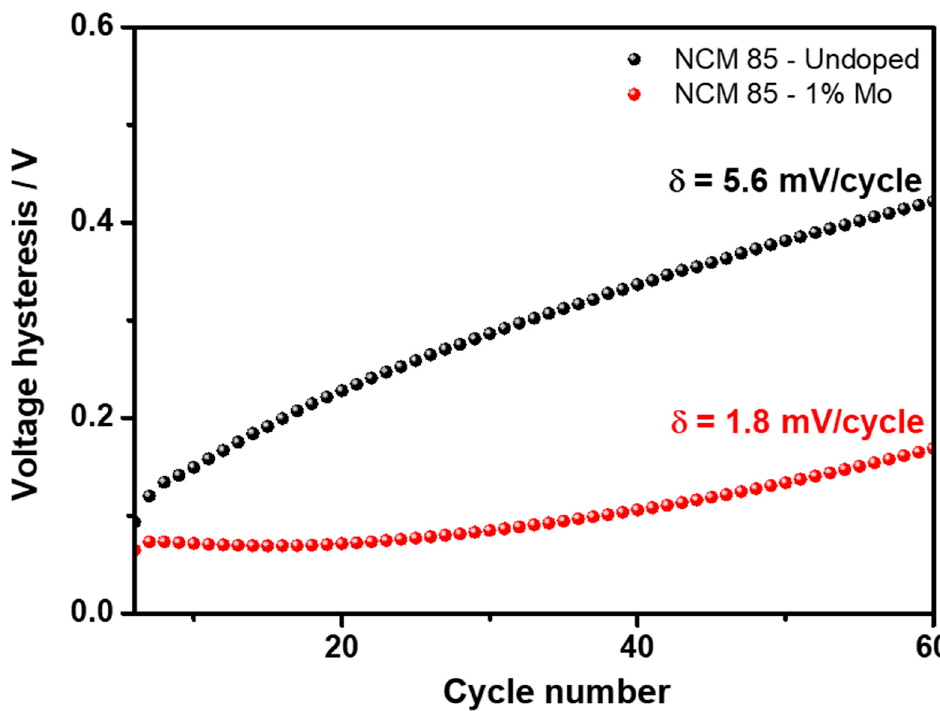
Figure 7. The voltage hysteresis measured from cycling performance (Figure 6a) of electrodes comprising undoped and 1 at. % Mo-doped NCM85 materials, at 30 °C. Evolution of the voltage hysteresis ( δ , mV/cycle) is indicated.